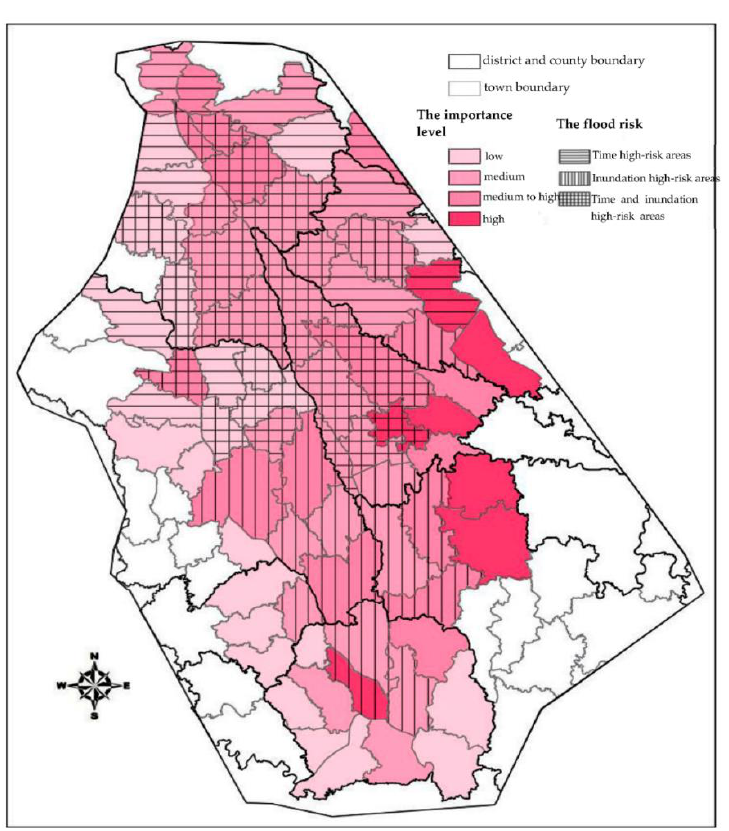
Figure 12. Flood risk map incorporating importance and flood hazard levels.